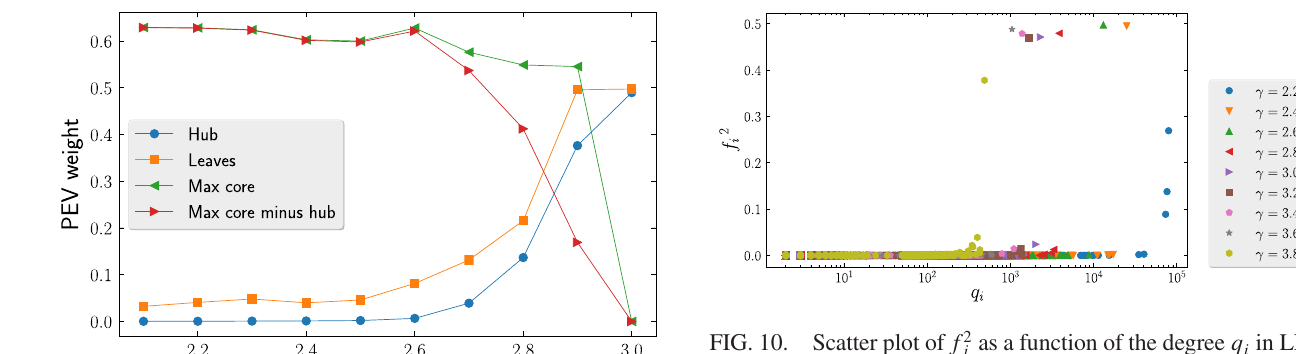
as a function of the degree q i